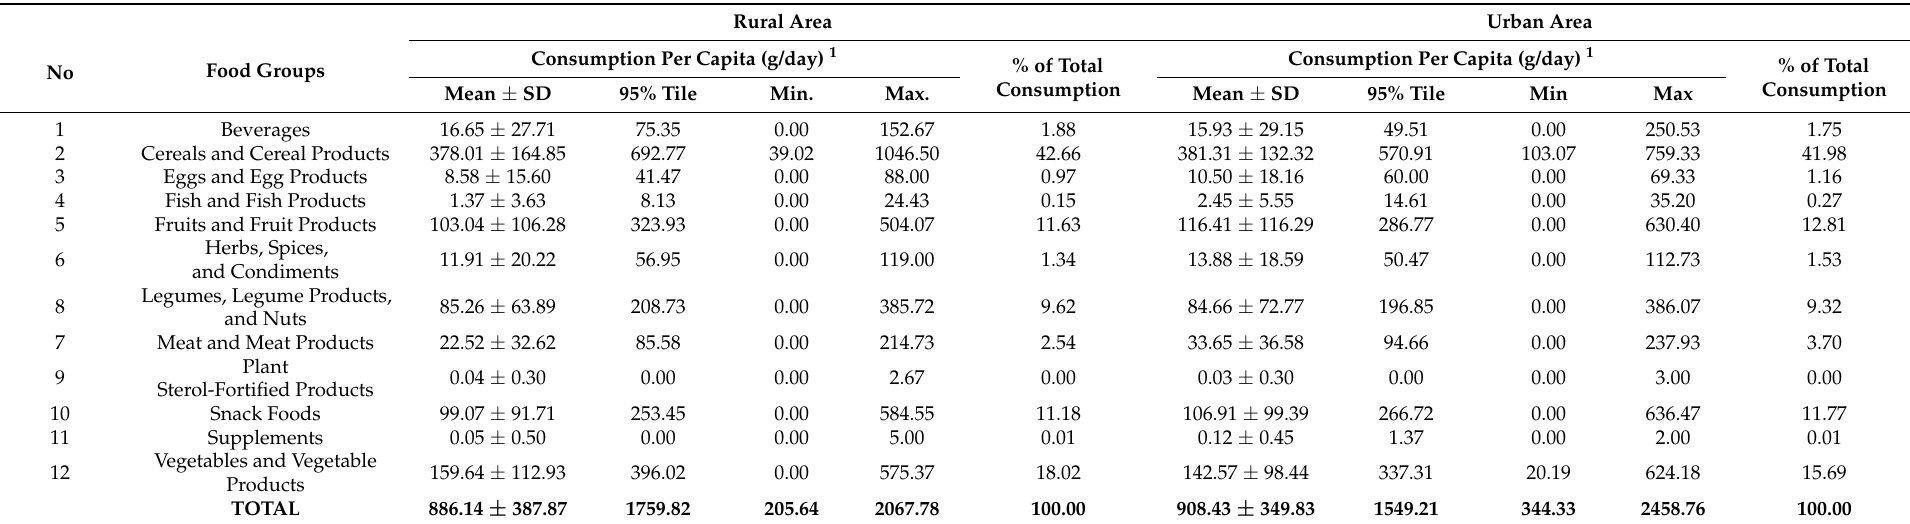
Table 2. Consumptions of foods predicted to contain plant sterols, divided into 12 food groups, in rural and urban area of Bogor.